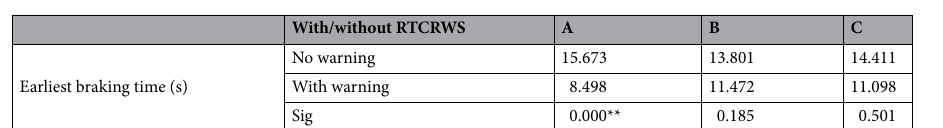
Figure 10. Distribution of safer and dangerous drivers at 3 intersections with or without warning.